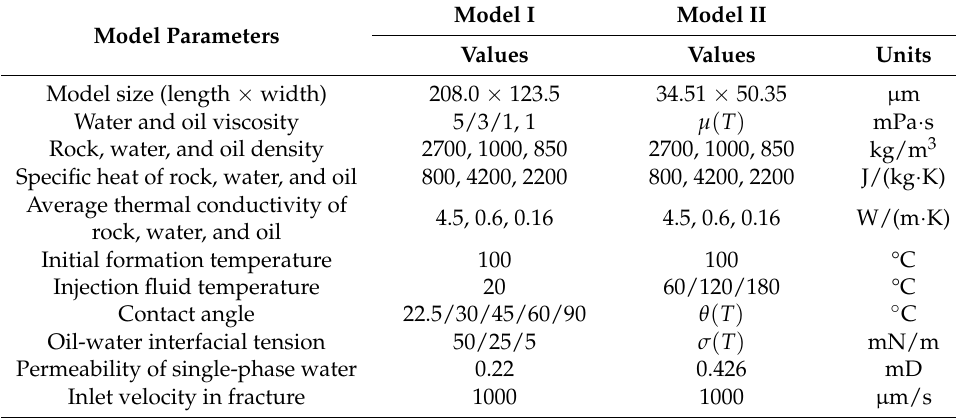
Table 1. Main computational parameters of the